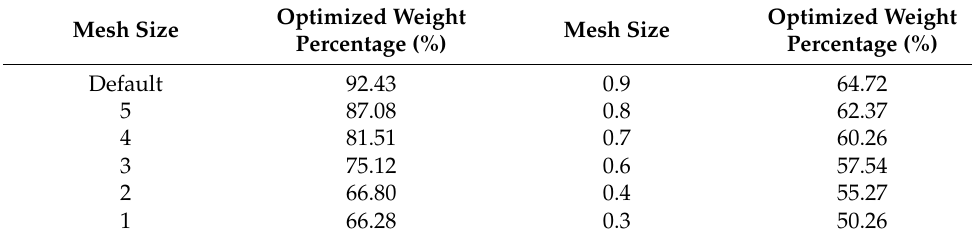
Table 3. Optimized weight percentages.